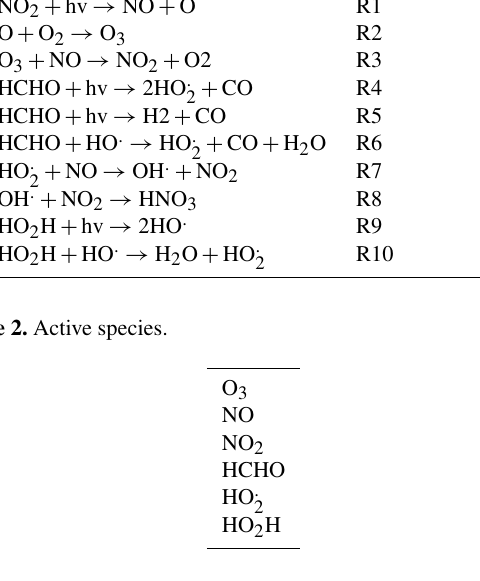
Table 1. Reaction mechanism.